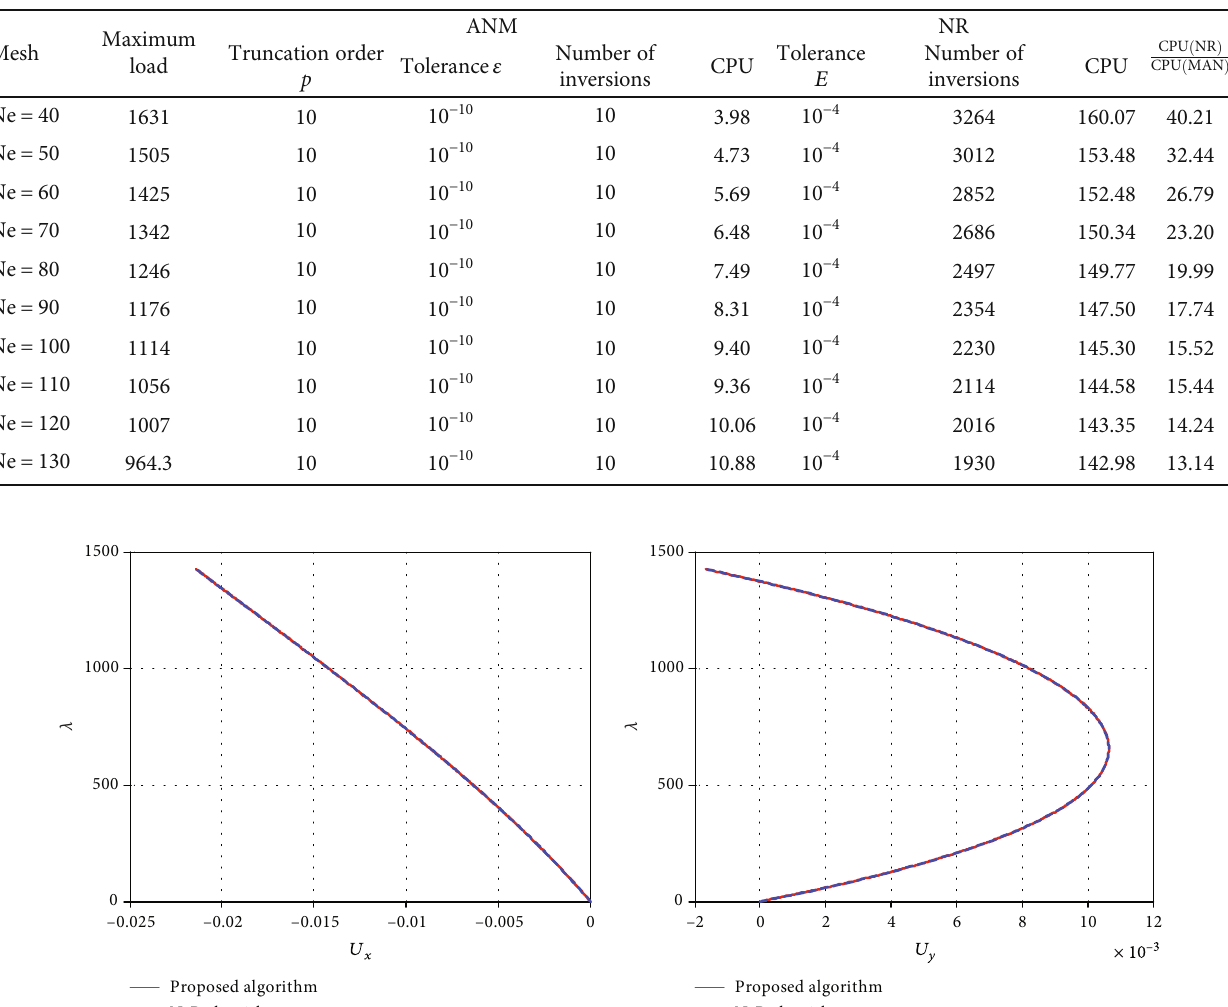
Table 2: In fl uence of the mesh on the CPU computation time used by high-order and Newton-Raphson algorithms for di ff erent meshes and for truncation order p = 10 .